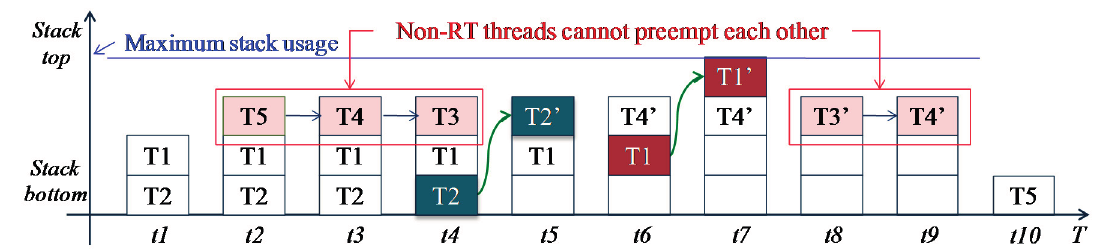
Figure 13. The thread scheduling process and the maximum stack usage in LiveOS